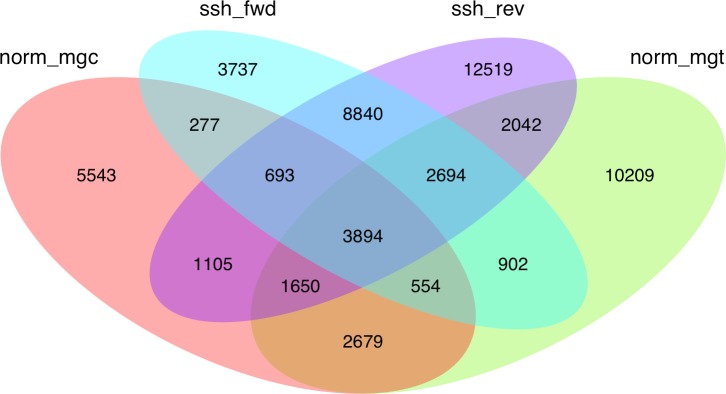
Venn diagram showing the extent of redundancy between the different libraries constructed in the present work: norm_ mgc, normalized control library; norm_mgt, normalized exposed library; ssh_fwd, SSH forward library; ssh_rev, SSH reverse library.